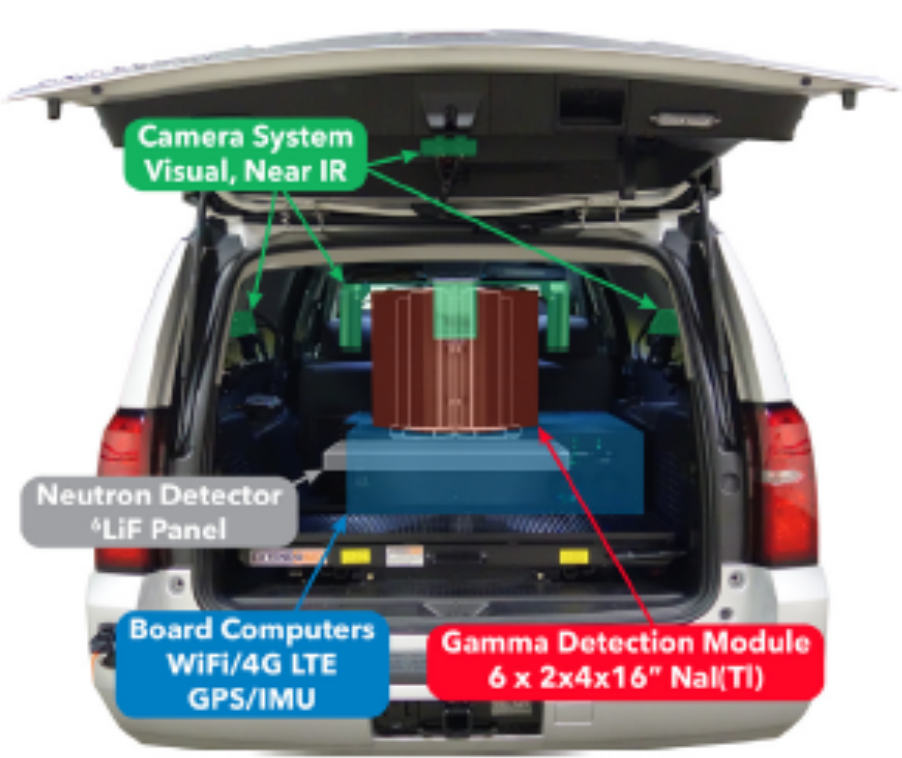
Figure 15. Vehicle used on the Mobile urban radiation search (MURS) project. Reproduced, with permission, from Reference [208]; copyright Elsevier